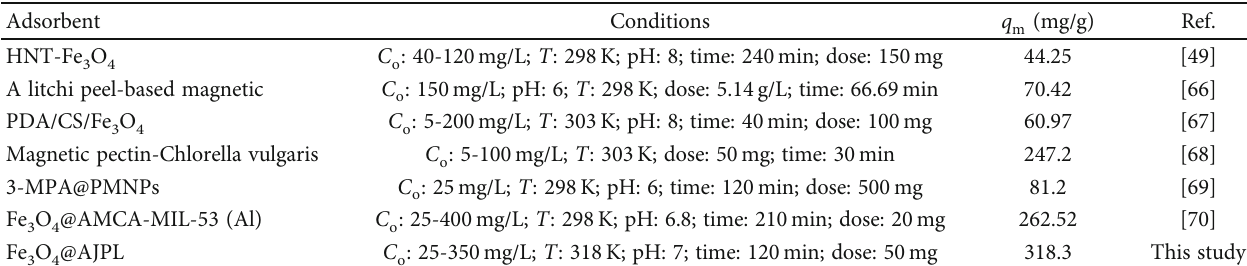
O @AJPL nanocomposite with other magnetic adsorbents. 3 4